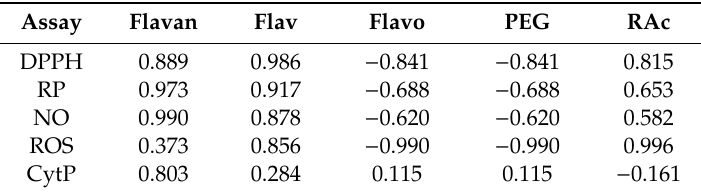
Table 3. Correlation coe ffi cients between the amounts of phenolic components of M. aquatica, L. dentata and L. cardiaca hydroethanolic extracts and the data from the radical scavenging, 5-LOX inhibition assays and biological experiments. Assay Flavan